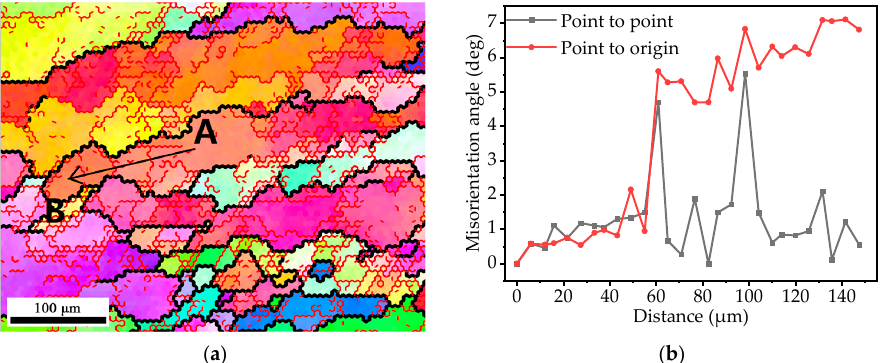
Figure 14. dDRX of the Ti − 65541 alloy in region C: ( a ) EBSD map, ( b ) the map of misorientation.